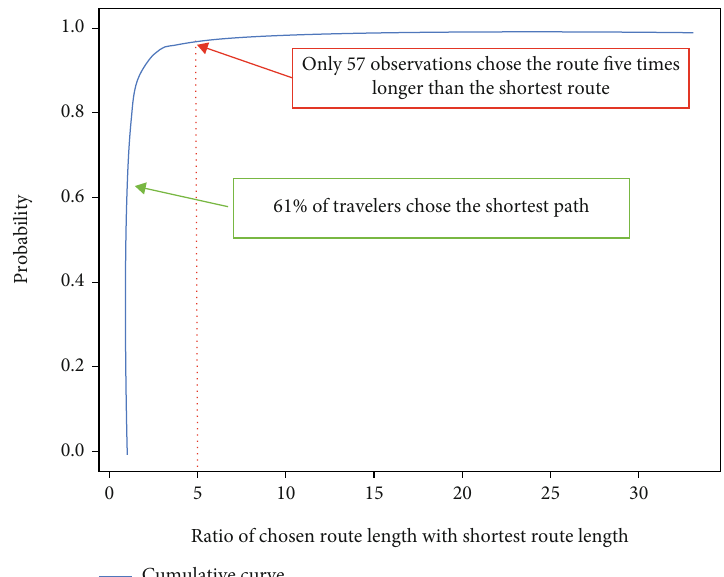
Figure 7: Distribution of the relative di ff erences of length between chosen route and the shortest